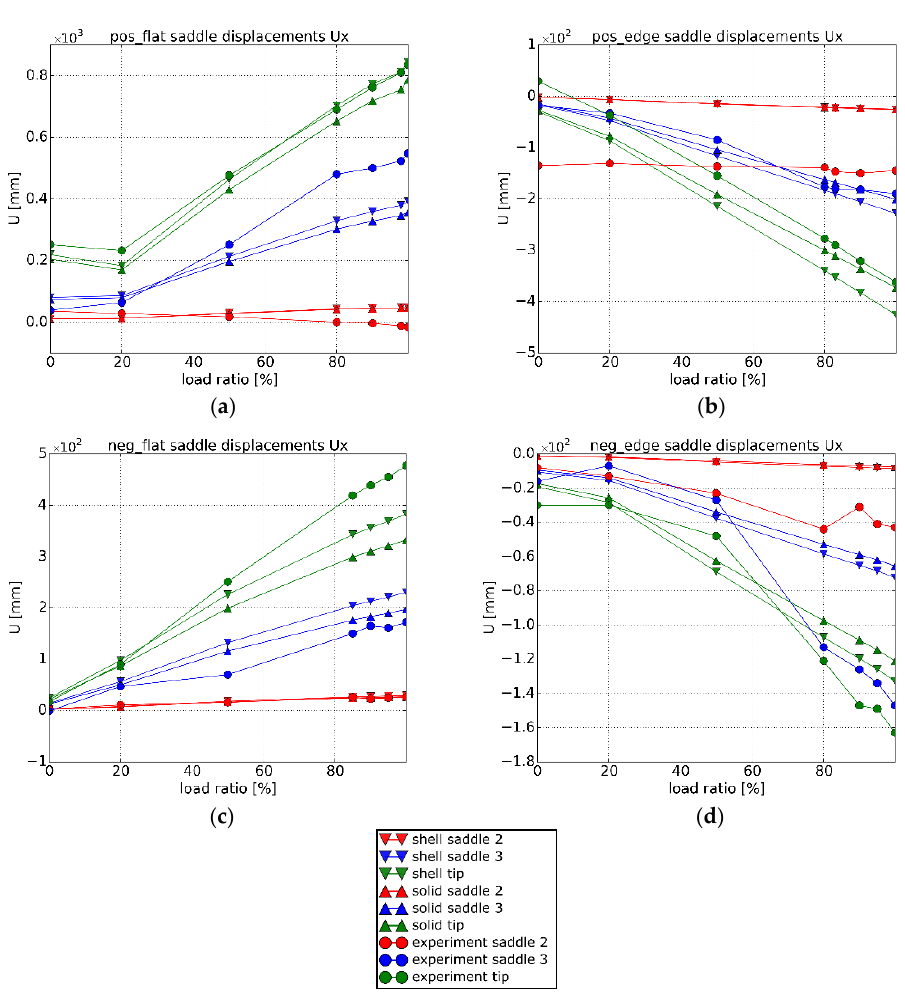
Figure 10. Saddle displacements Ux for the different load cases. ( a ) Positive flatwise load case; ( b ) positive edgewise load case; ( c ) negative flatwise load case; ( d ) negative edgewise load case.